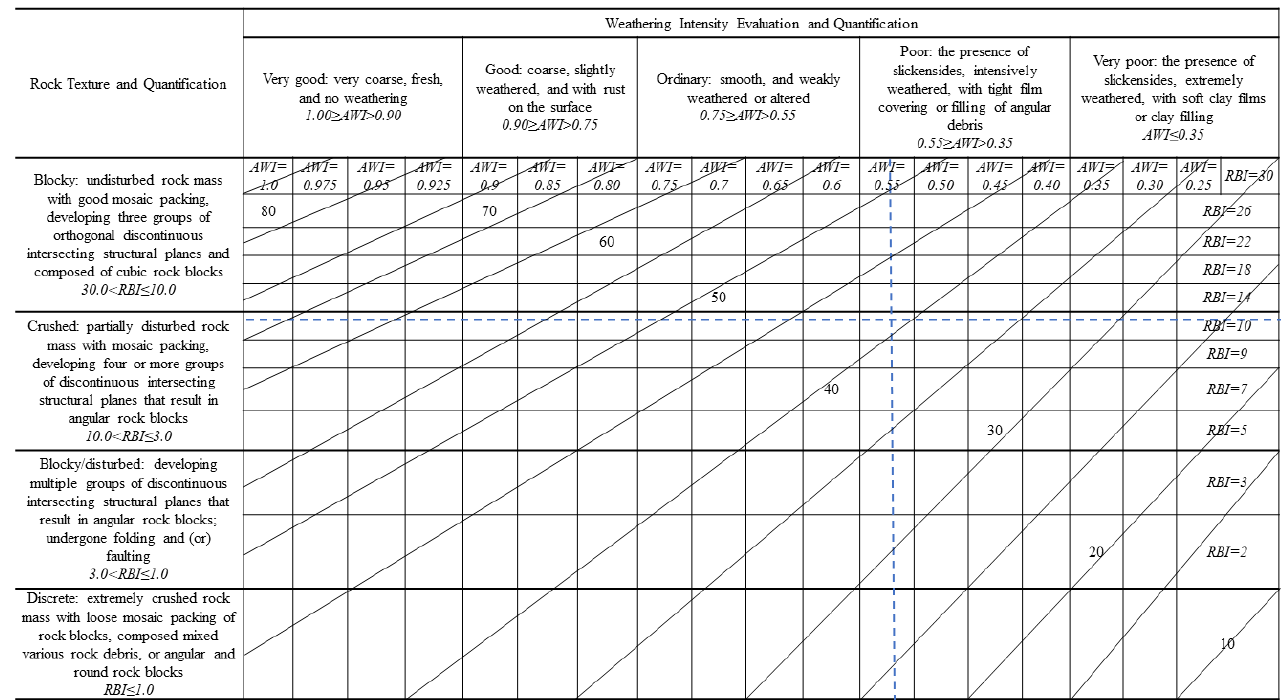
Figure 2. GSI quantification of rock mass [31]. Note: The following example is used to demonstrate how to use the above table. In the case of AWI = 0.52 and RBI = 9.7, two vertical and horizontal lines are drawn according to the index values (the dashed lines in the table); the intersection point is found between 40 and 45; the GSI value at the point is calculated via linear interpolation (the result is 41).